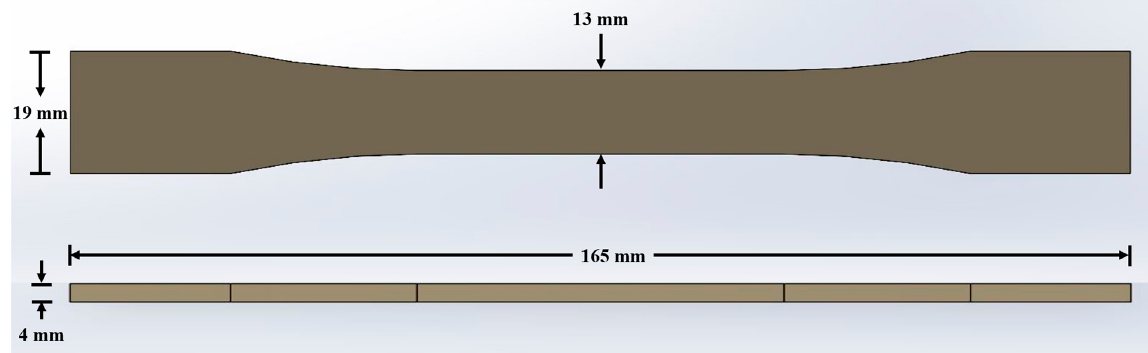
Figure 1. CAD Model for ASTM D638 Type I Specimen with Dimensions.